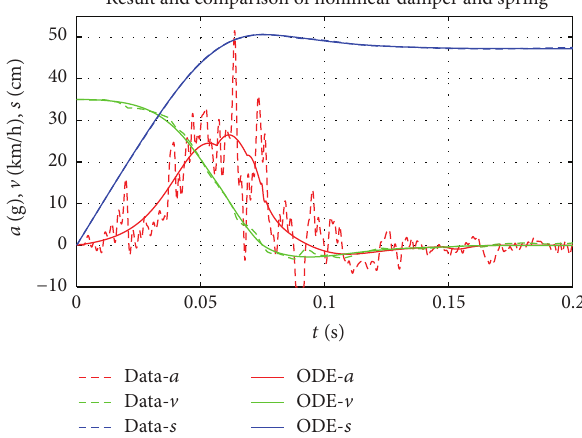
Figure 14: Results and comparison between optimized model and experimental crash data.